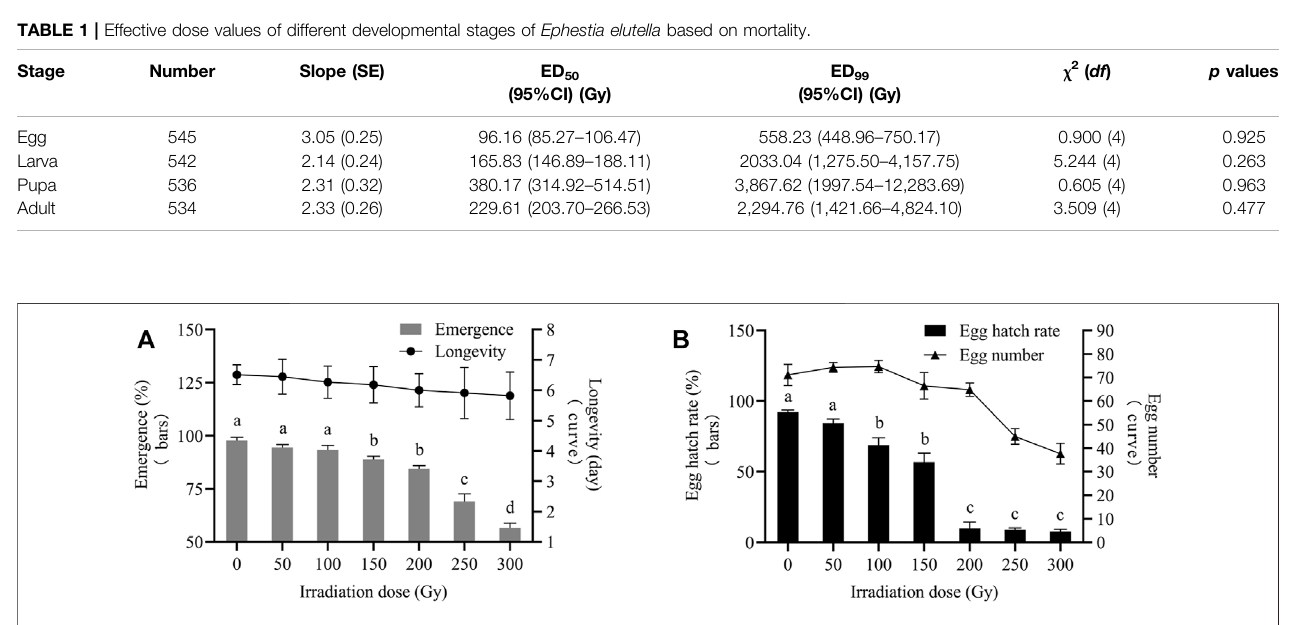
FIGURE3| BiologicalreactionsofX-ray-irradiated E.elutella malepupae.Effectsofpupalirradiationonemergenceandlongevity (A) .Effectsofpupalirradiationon egg number and egg hatch rate (B) . Error bars represent the SD from the mean of three independent replicates. Different letters indicate signi fi cant differences among treatments as determined by one-way ANOVA followed by Tukey ’ s HSD test ( p -value <